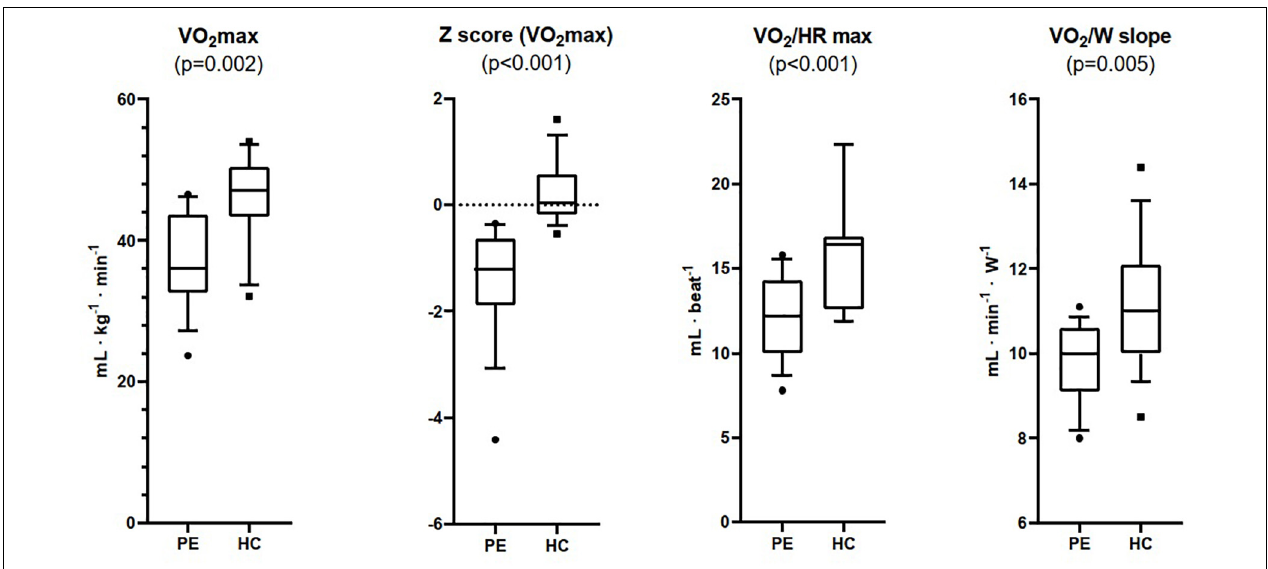
FIGURE 1 | Maximum oxygen uptake (VO 2 max), Z Score for VO 2 max, maximum oxygen pulse (VO 2 /HR max), and work efficiency (VO 2 /W slope) measured at Cardiopulmonary Exercise Testing in patients with pectus excavatum (PE, n = 15), and healthy controls (HC, n = 15).